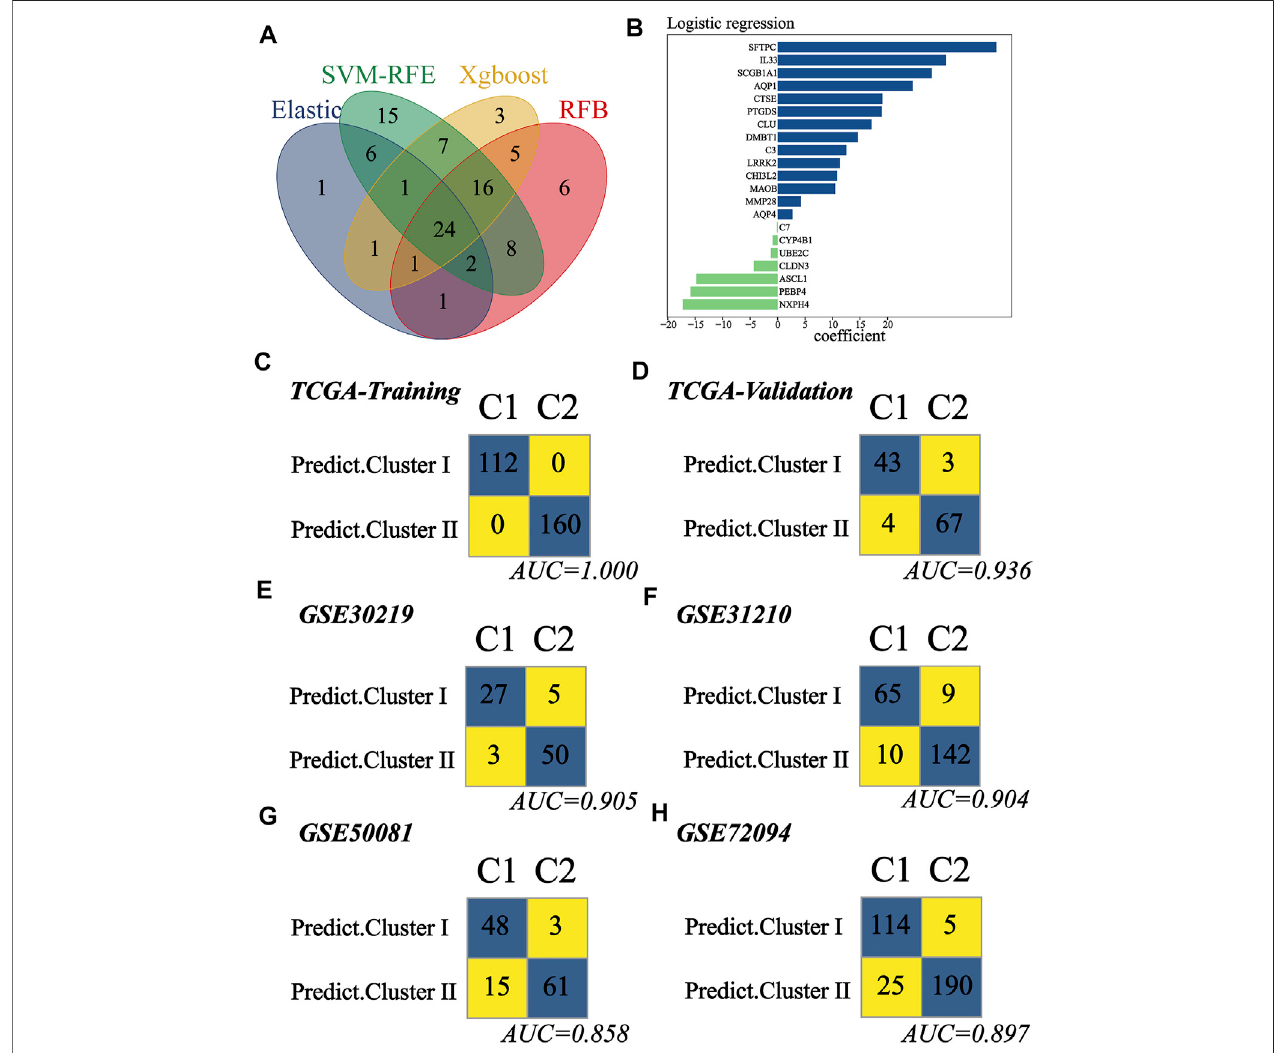
FIGURE 7 | Construction and validation of the subtype predictor. (A) Venn diagram identi fi ed 24 genes shared by ElasticNet, SVM-RFE, RFB, and XGBoost machine learning. (B) Coef fi cient of the 21 common genes shared by all studying cohorts. The combination of these 21 genes was used to generate the subtype predictor using logistic regression. (C – H) Confusion matrices of binary results of the subtype predictor for TCGA training cohort, TCGA validation cohort, GSE30219, GSE31210, GSE50081, and GSE72094.